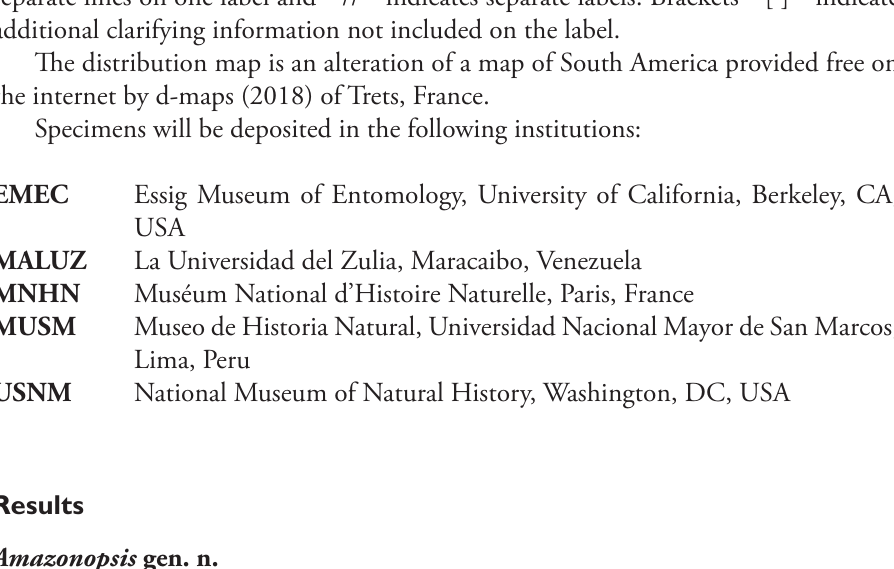
Figs 1–10 Type species. Amazonopsis theranyi sp. n. Other species. Amazonopsis camachoi sp.